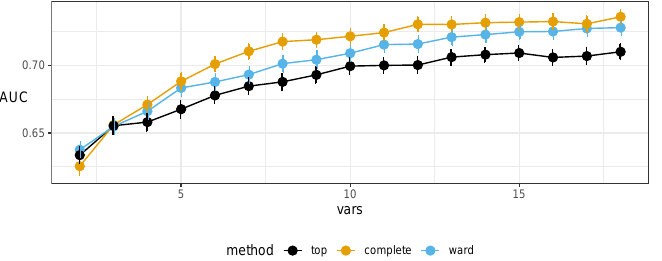
Figure 1. Plots of the area under the receiver operating characteristic curve (AUC) of the Random Forest classifiers, using markers selected by the top- n approach and two variants of hierarchical clustering inside our proposed protocol (complete linkage and Ward’s criterion). These results were obtained without external cross validation (CV) or resampling, but from inside of the protocol itself (that is, under the protocol’s internal CV). Error bars denote the standard error.